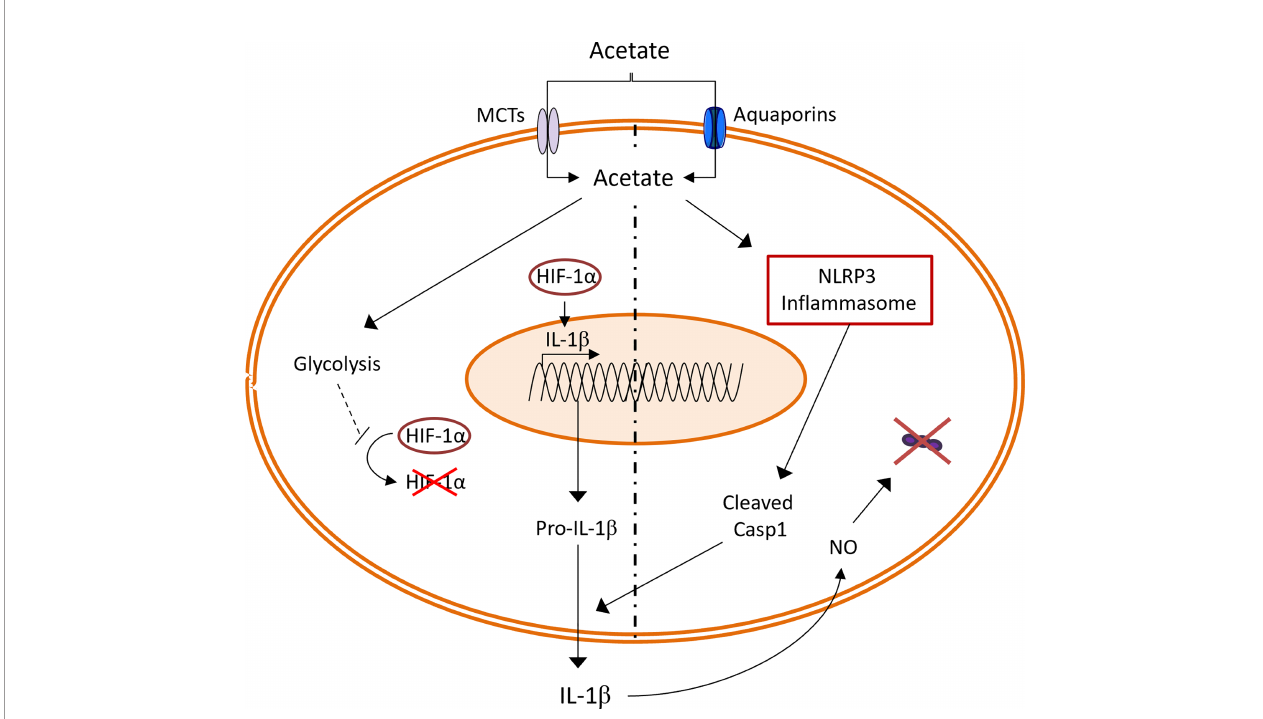
FIGURE 7 | Summary of the effect of acetate on S. pneumoniae stimulated macrophages. Acetate increases the glycolysis, leading to higher HIF-1 a activation. HIF- 1 a transcription factor enhance expression of Il1b gene. At the same time, acetate dependent on NLRP3 in fl ammasome increases IL-1 b secretion. In an autocrine manner, IL-1 b increases the production of nitric oxide (NO), which leads to S. pneumoniae